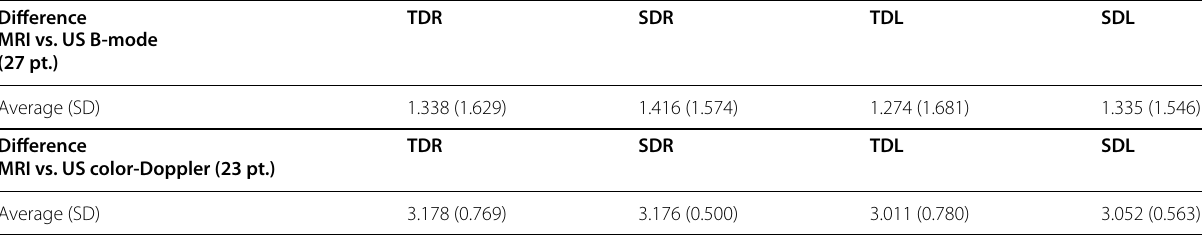
The average difference between MRI and US B-mode measurements has much lower values than the average difference between MRI and US color-Doppler mode for each diameter MRI magnetic resonance imaging, US ultrasound, SD standard deviation, TDR , transverse diameter right, SDR , sagittal diameter right, TDL transverse diameter left, SDL sagittal diameter left